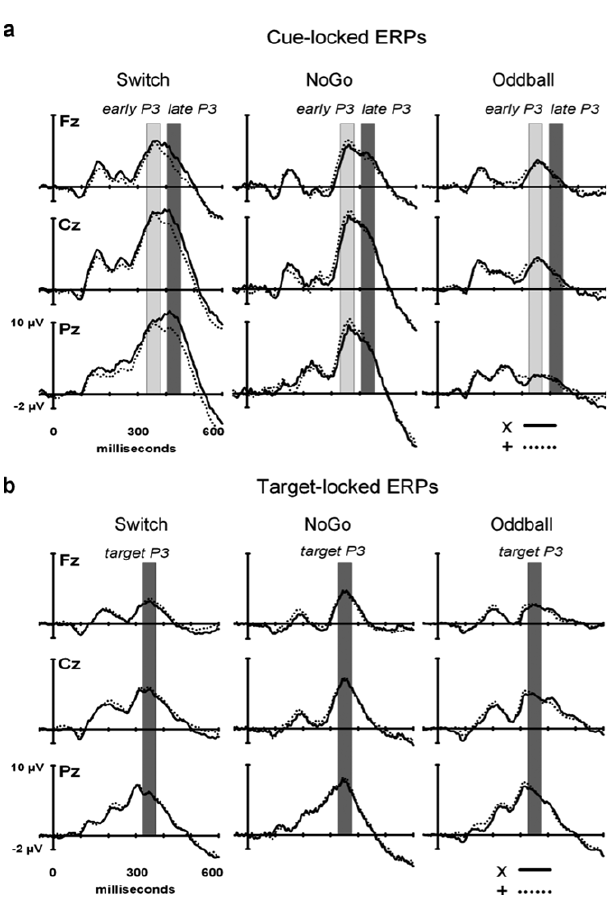
Figure 4. Event-related potentials (ERPs) at 3 midline electrodes (Fz, Cz, Pz). (A) Grand cue-locked ERPs elicited by black symbols ‘ x ’ and ‘ + ’ in the Switch, NoGo, and Oddball conditions. (B) Grand target-locked ERPs to black symbols ‘ x ’ and ‘ + ’ in the Switch, NoGo, and Oddball task conditions (with 1st, 2nd and 3rd targets trials collapsed). Gray bars show the latency windows for amplitude measurements of the early and late aspects of cue-locked P3 activity, and for target-locked P3